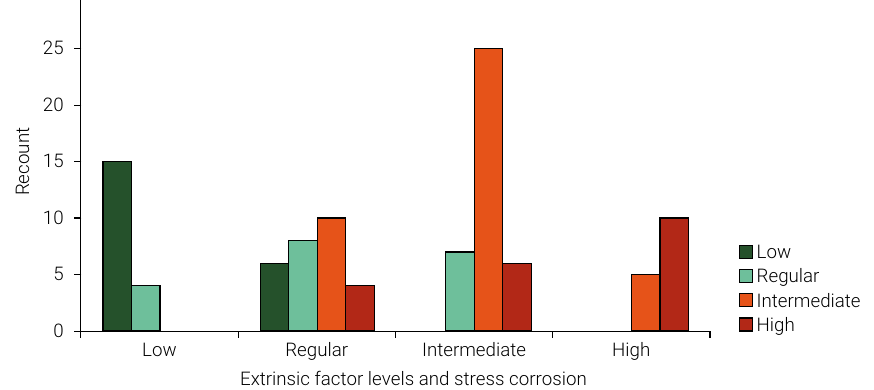
Figure 5. Percentage of extrinsic factor levels and stress